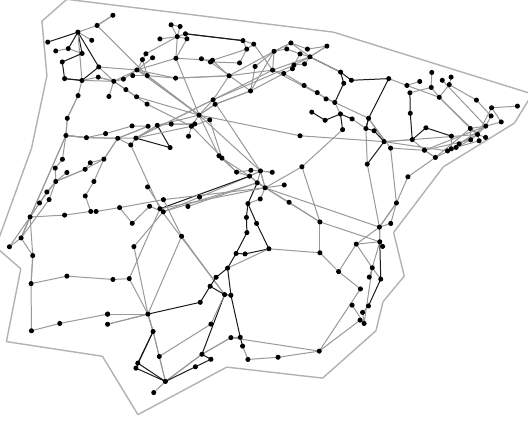
Figure 2. Iberian Peninsula transmission network. Table 7. Installed capacity of generating